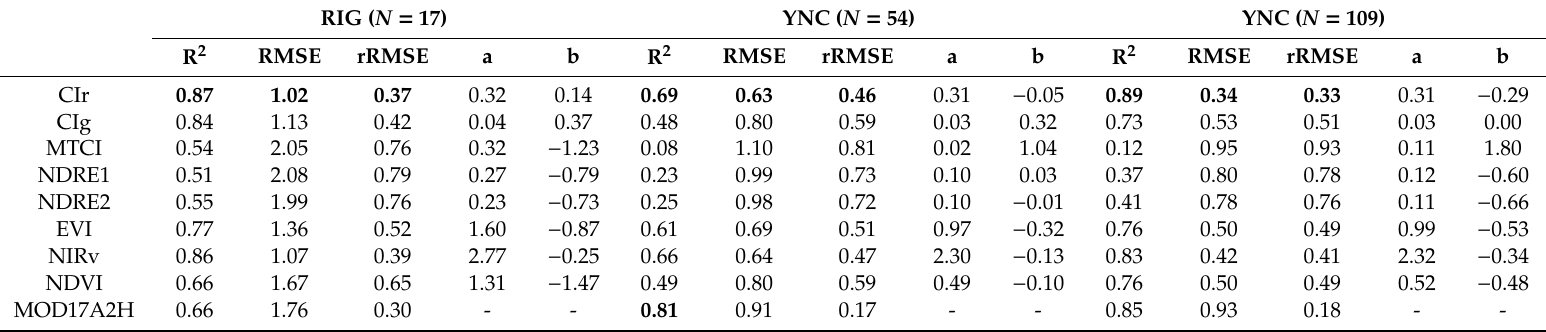
Table 4. The algorithm results for the 16-day average daytime GPP estimated at grassland (GRA) sites, with the determination coe ffi cient ( R 2 ), RMSE (unit in gC · m − 2 · day − 1 ), and rRMSE presented. We adopted the equation GPP EC = a × VI × PAR + b here, where the VI is the rebuilt time series, and PAR is the photosynthetic active radiation. The number of samples at each site is presented in parentheses after the site name. The first two series of results are based on rebuilt VIs in a 16-day standard interval. The series YNC ( N = 109) is based on rebuilt VIs in eight-day standard intervals. The numbers in bold represent the highest R 2 , lowest RMSE, and lowest rRMSE